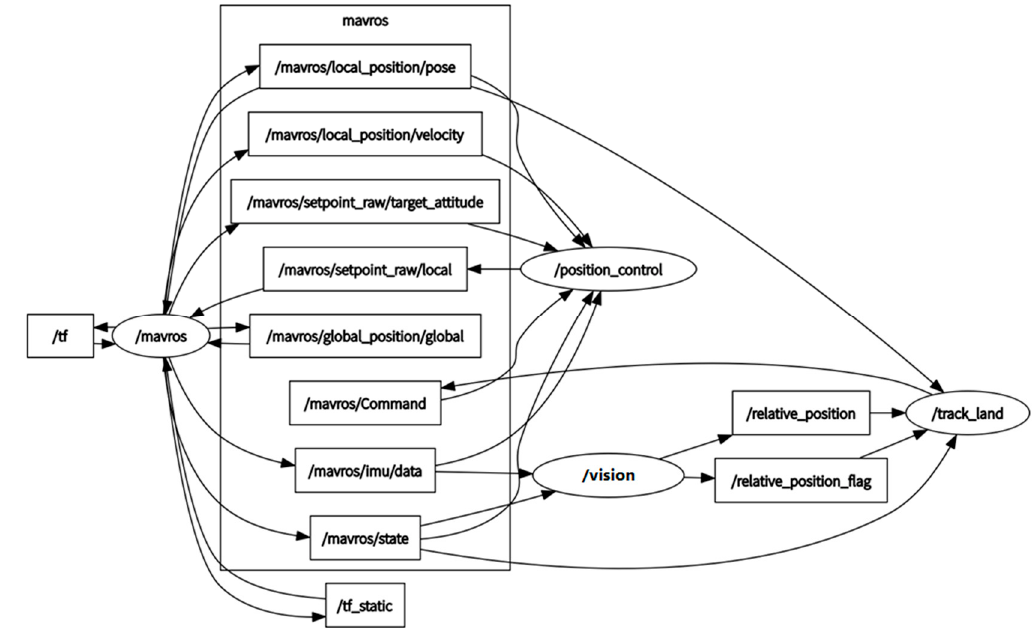
Figure 10. Robot Operation System (ROS) nodes and topics created to implement the algorithm.